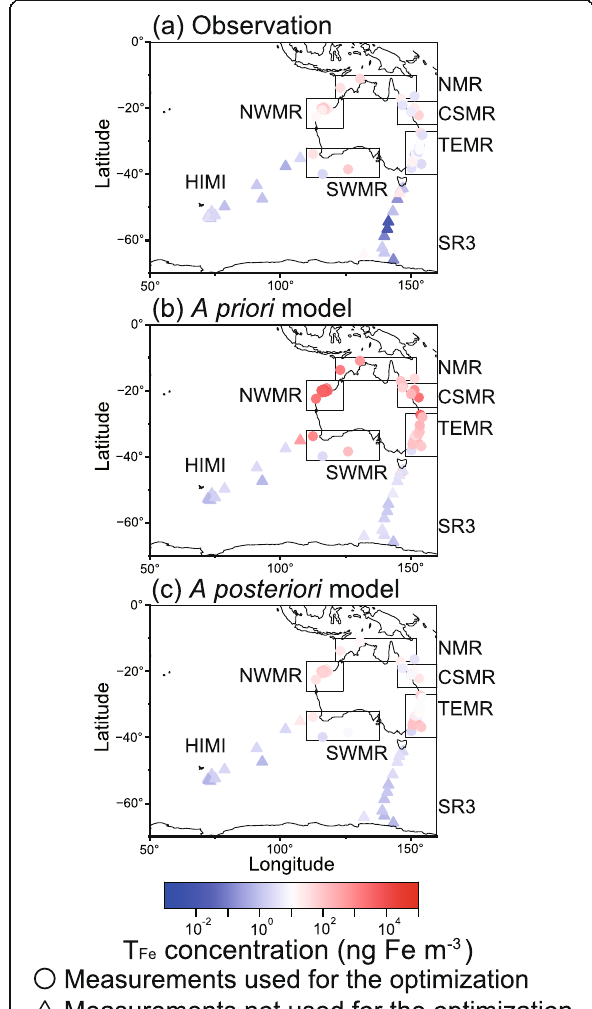
Fig. 5 Spatial distribution of T Fe concentrations (ng Fe m – 3 ) in aerosols for a observations, b a priori model estimates, and c a posteriori model estimates over the 70°E – 150°E and 10°S – 70°S sector of the